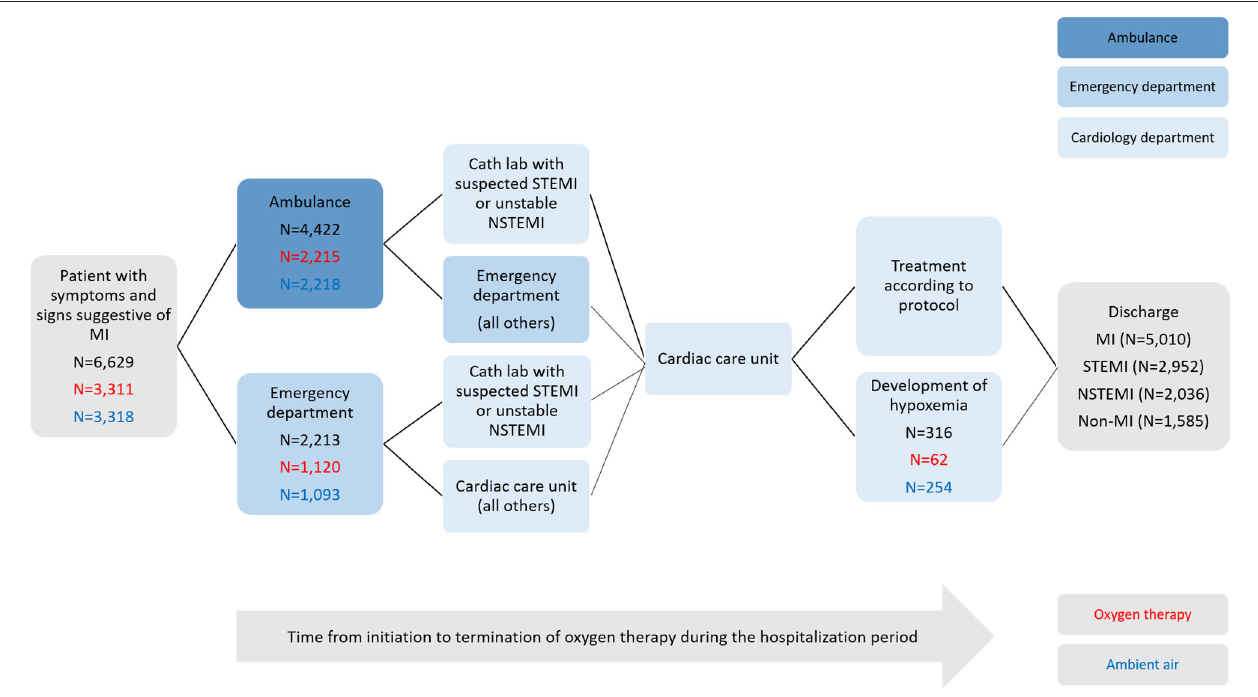
FIGURE 1 | Study flow chart. Eligible patients presenting to the ambulance service, emergency departments, or cardiology department (cath lab or cardiac care units) of participating hospitals with suspected myocardial infarction were evaluated for inclusion. Shown are the numbers of patients who were enrolled in the main study, randomly assigned to a study group (in black: total count; in red allocated to oxygen therapy; in blue allocated to ambient air), treated according to protocol or developed hypoxemia, and discharge diagnoses.